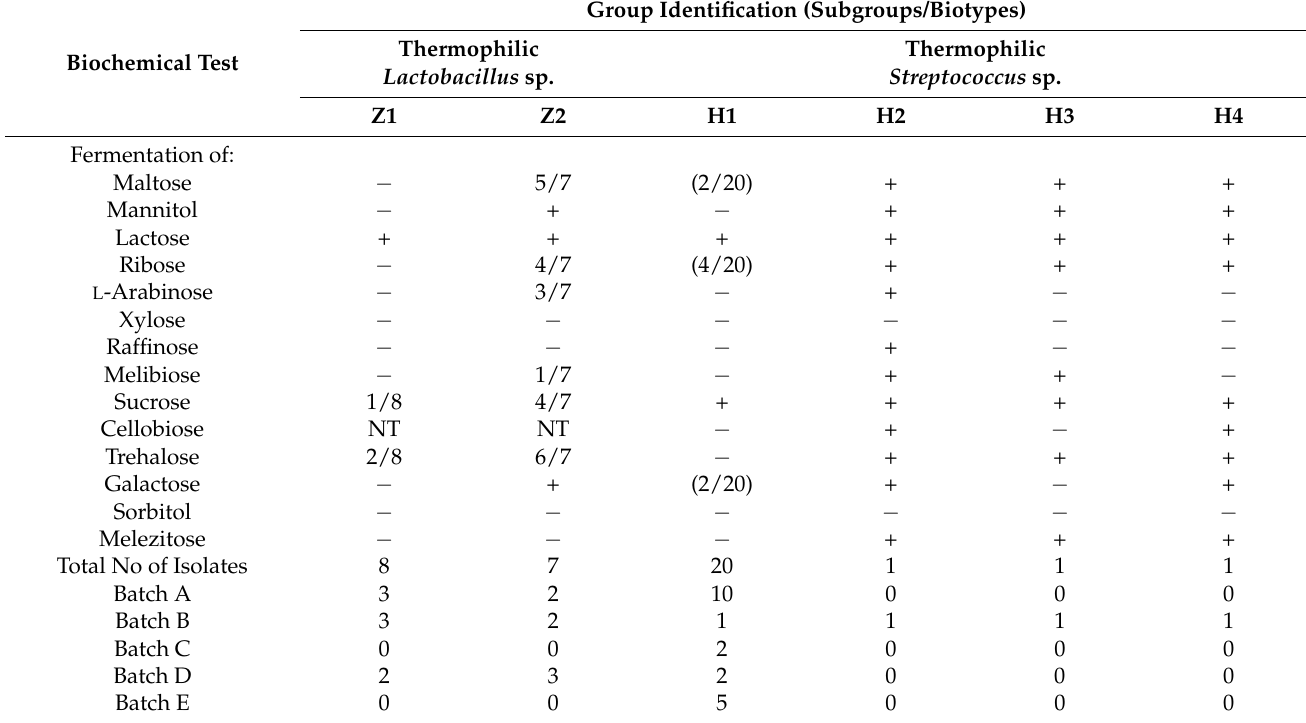
Table 6. Biochemical characterization of 38 thermophilic LAB isolates from five retail RTE Galotyri-like acid-curd cheese batches and their numerical distribution in each cheese batch.